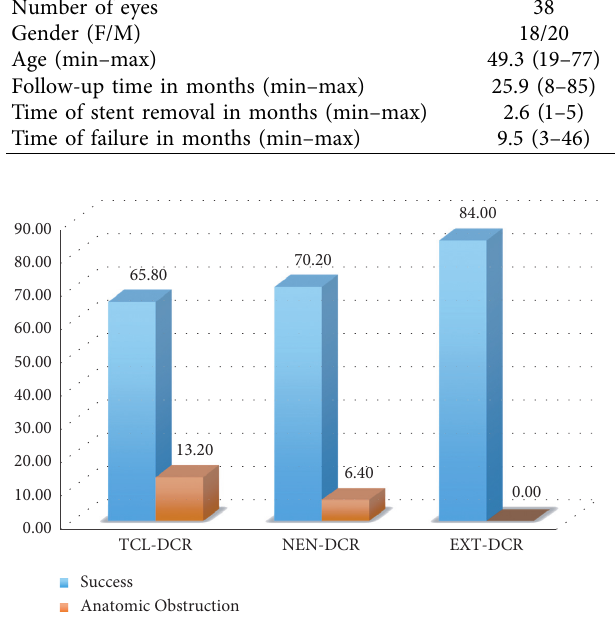
Figure 3: Three different surgical techniques’ outcomes.